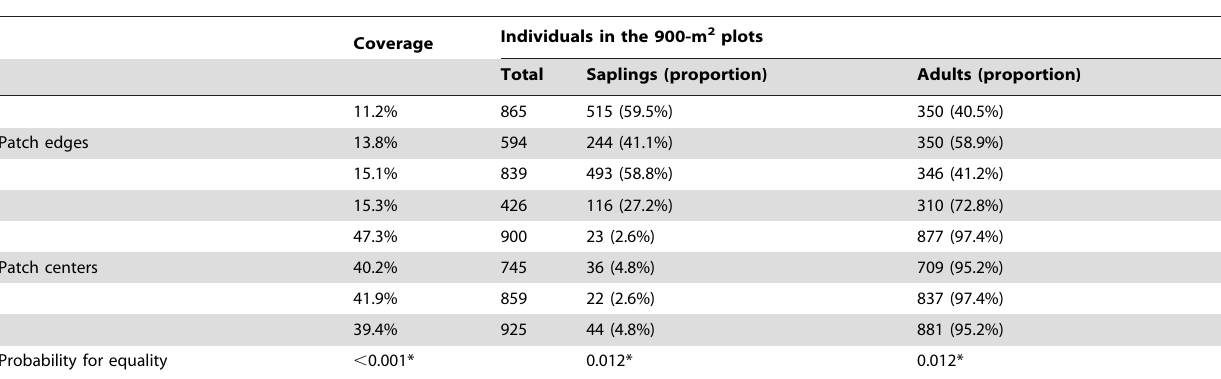
Table 1. Coverage and population structure of A. ordosica in the four